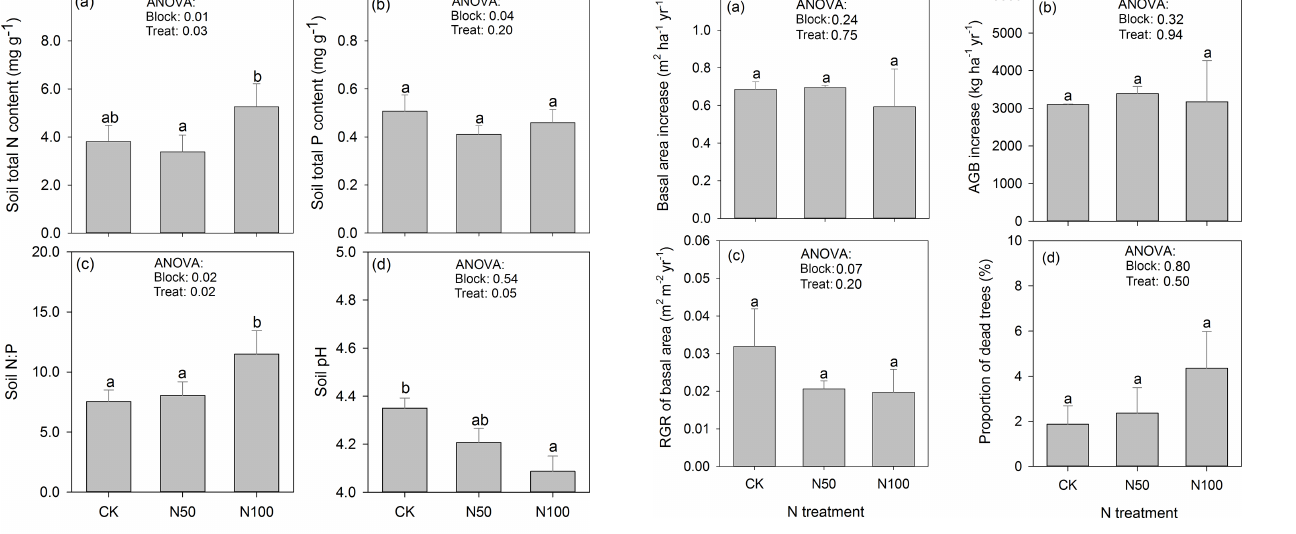
Figure 2. Effects of N fertilization on the growth and mortality of all trees (mean ± SE). (a) Absolute basal area increase of all trees, (b) aboveground biomass increase of all trees, (c) relative growth rate of total tree basal area, and (d) the proportion of all dead trees. The proportion of dead trees was calculated using the aboveground biomass of all dead trees during the experiment divided by the total aboveground biomass of all trees in 2014. Numbers in these figures indicate the results of ANOVA. The N treatment on the x axis rep- resents three levels of N fertilization: CK (0kg Nha − 1 yr − 1 ) , N50 (50kg Nha − 1 yr − 1 ) , and N100 (100kg Nha − 1 yr − 1 )